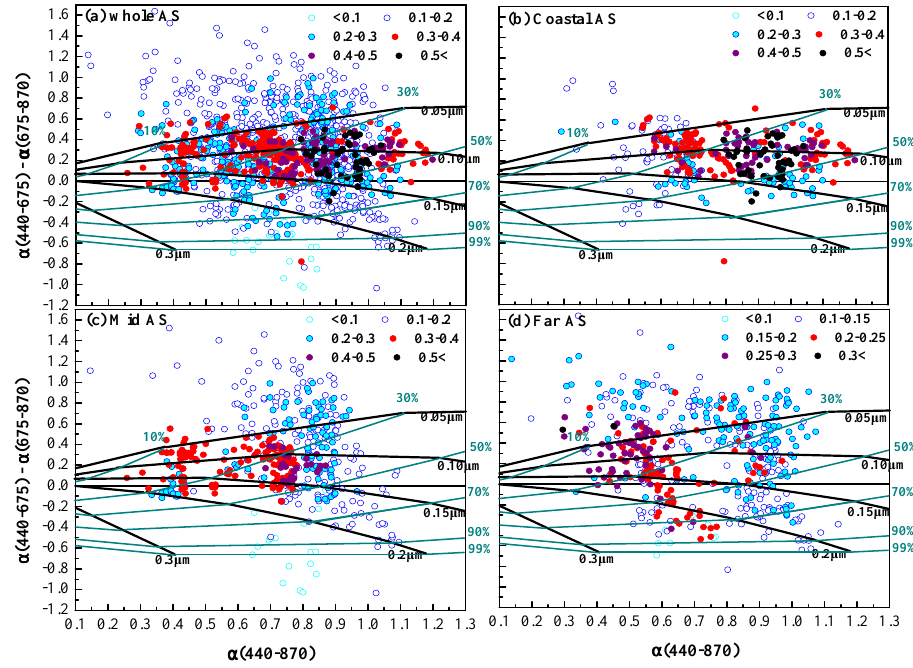
Figure 11. Fig. 11. ˚Angstr¨om exponent difference, dα = α (440–675) – α (675–870), as a function of the α 440 − 870 and AOD 500 (color scale) over whole AS (a) , coastal AS (b) , mid AS (c) , and far AS (d)